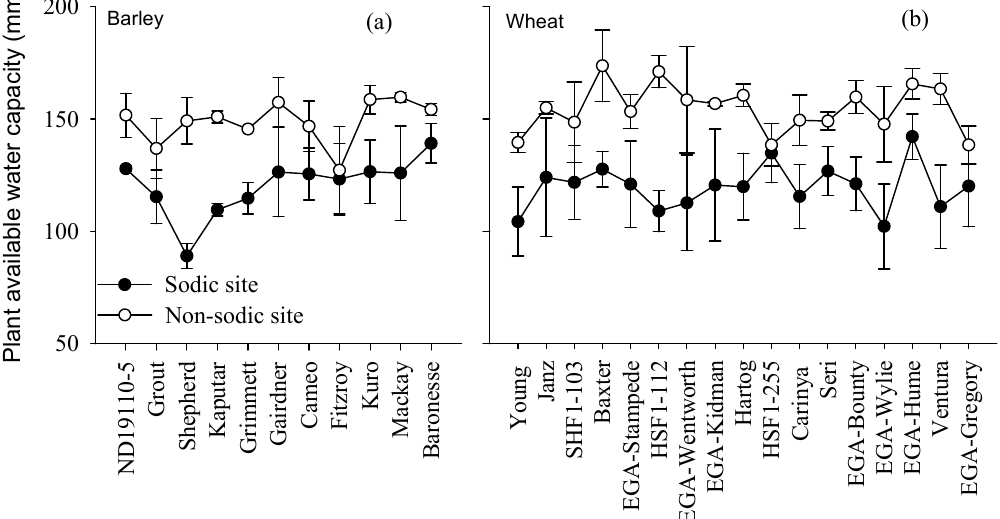
Figure 4. Plant available water capacity ranking of ( a ) barley and ( b ) wheat genotypes grown on a sodic site and a non-sodic site in 2008 at Goondiwindi in southern Queensland.